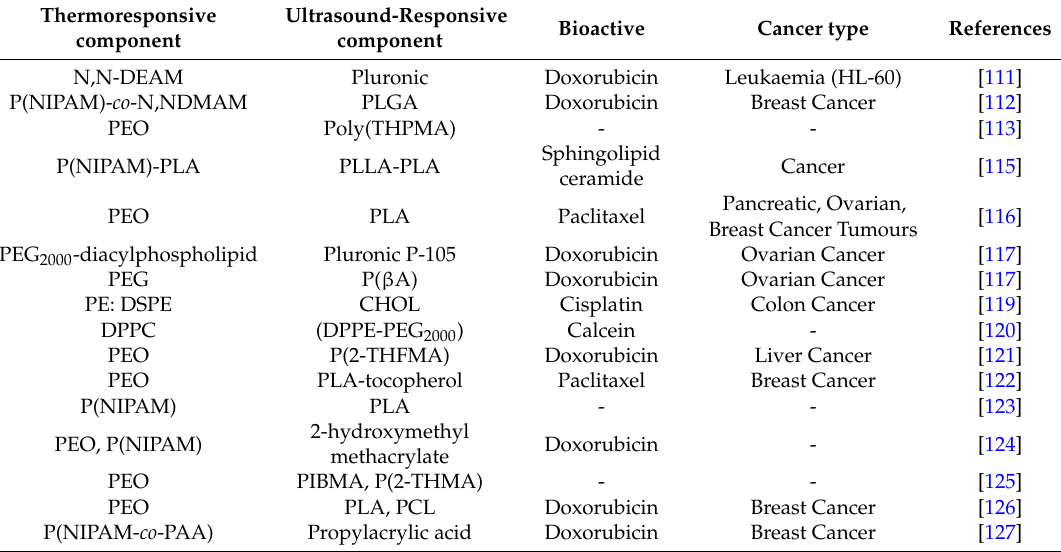
Table 3. Delivery systems incorporating thermo- and ultrasound-responsive